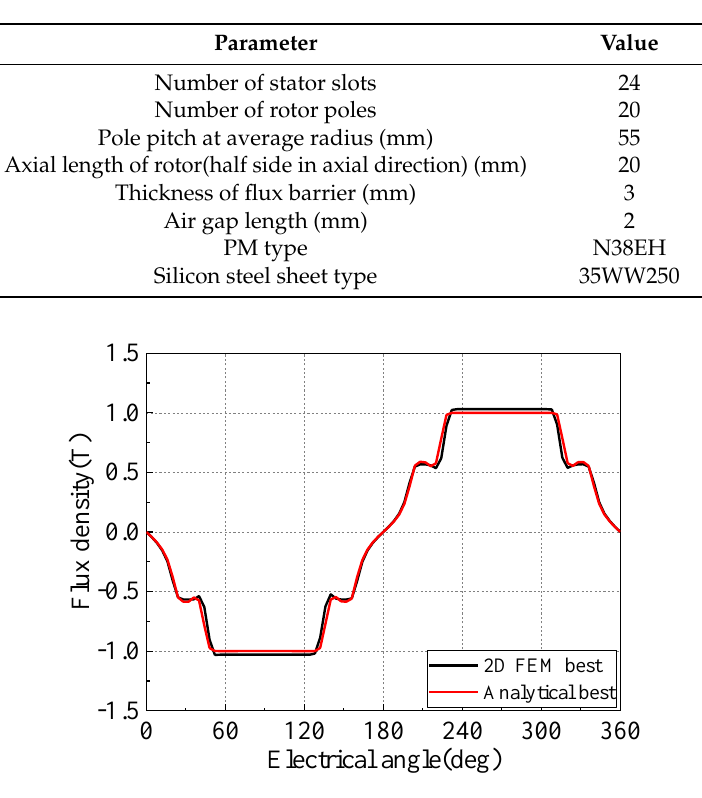
Table 3. Machine Parameters.